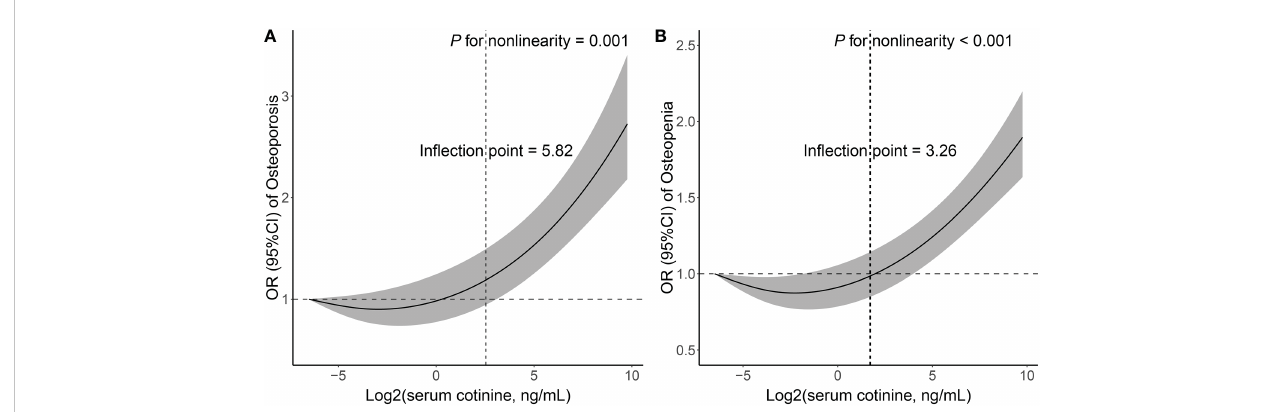
FIGURE 2 Associations between log2-transformed serum cotinine levels and the prevalence of osteoporosis (A) as well as osteopenia (B) .